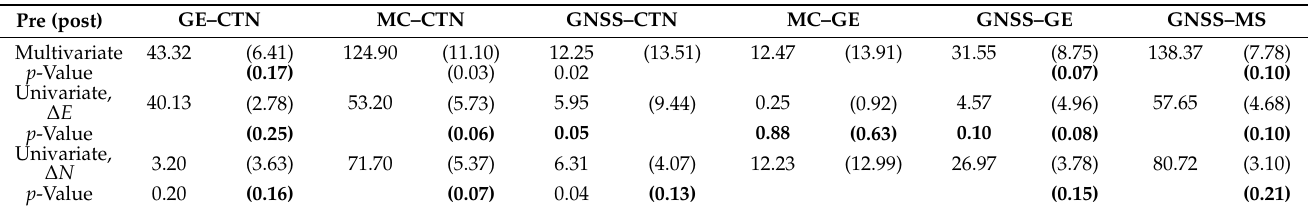
Table 6. Doornik–Hansen omnibus test for multivariate normality of the pairs ∆ E – ∆ N . The degree of freedom (df) = 4. Values after outliers’ removal are reported between parentheses. p -Values < 0.02 are omitted. The resulting bivariate normal distributions are highlighted in